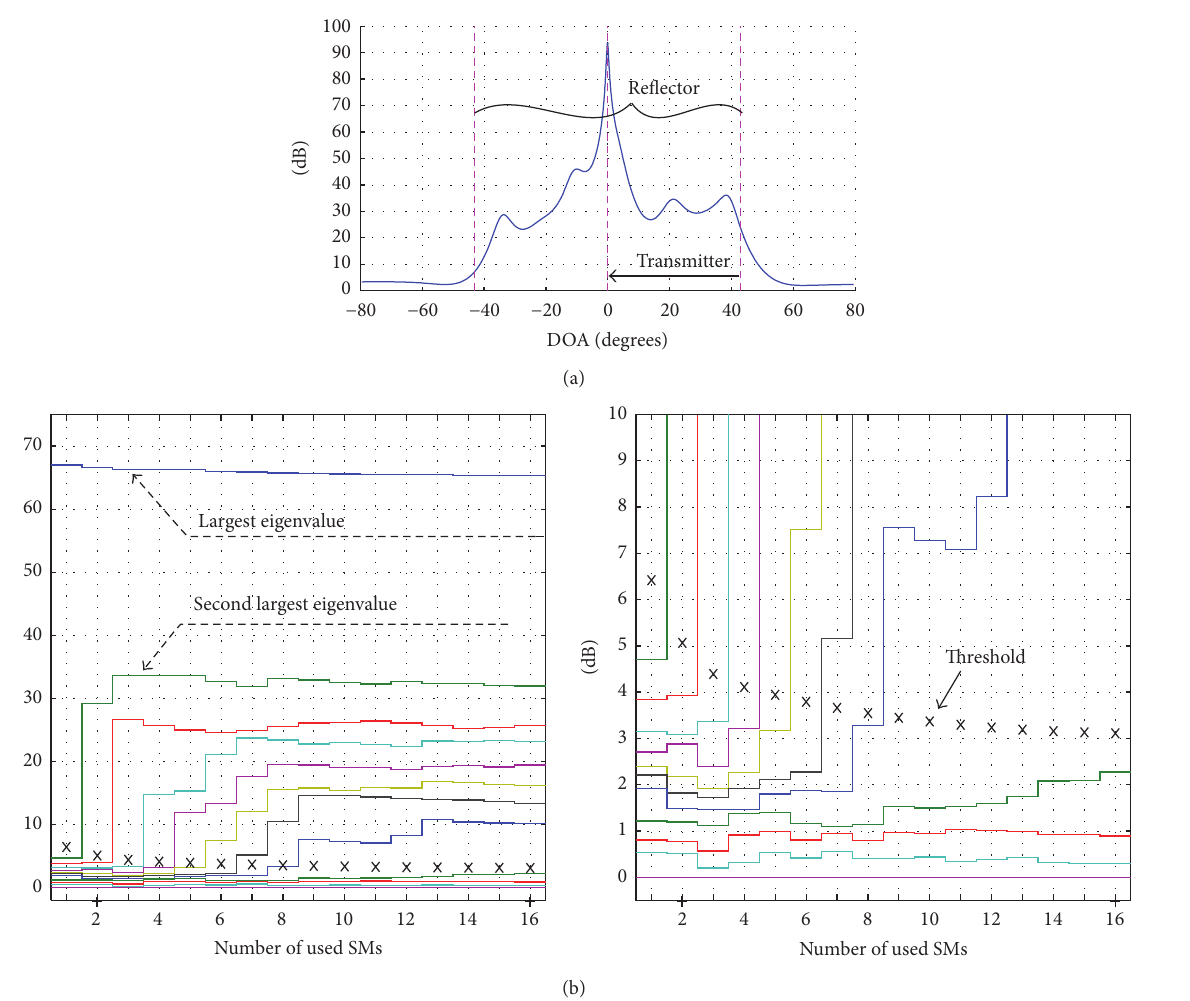
Figure 8: Measurement C1S. A single strong transmitter. (a) Capon DOA spectrum. Figure description in Figure 7. (b) Eigenspectrum. Zoom-in to the right. dB scale. See Section 3.3 for